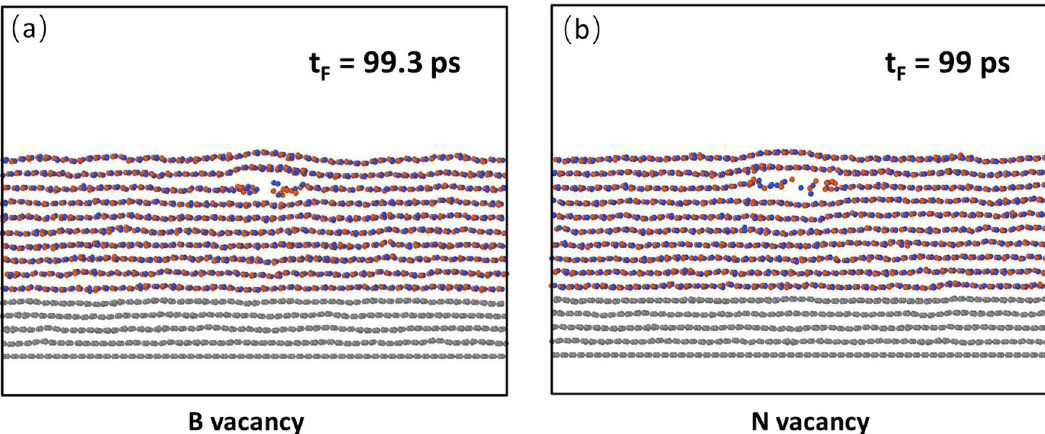
Figure 3. Effect of vacancy on the failure start time and location. ( a ) B vacancy and ( b ) N vacancy. In both cases, the vacancy is located in the middle of the 3rd layer of the heating zone, and the failure starts from the defect. The failure start time for B vacancy is 99.3 ps and that for N vacancy is 99 ps, indicating that there are almost no differences in the failure time and failure location for both types of defects. Both failure start times are much shorter than that of defect-free case, which is 135.75